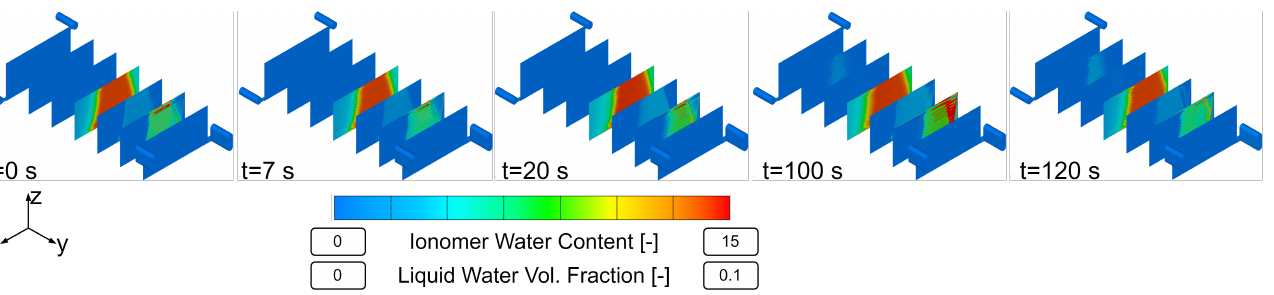
Figure 10. Exploded view of the fuel cell under investigation with liquid water volume fraction (channels, GDLs, and CLs) and membrane water content data at specific times. Parts in positive y - direction: (1) homogenized anode channels, (2) anode GDL, (3) anode CL, (4) membrane, (5) cathode CL, (6) cathode GDL, and (7) homogenized cathode